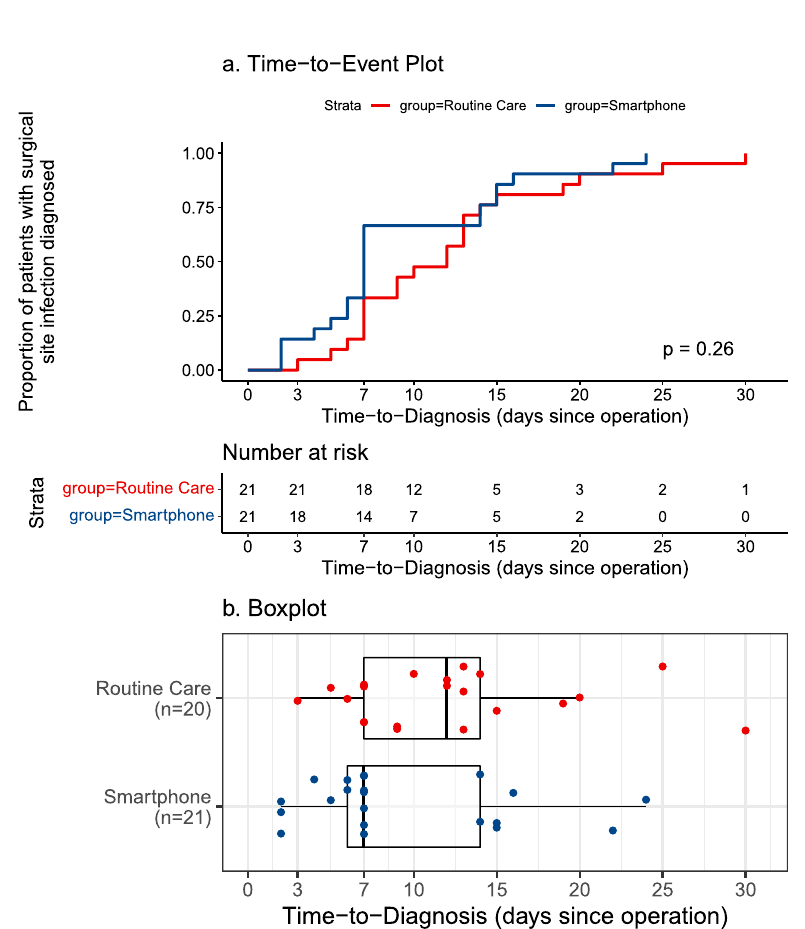
Fig. 2 Time-to-diagnosis (days) of surgical-site infection (SSI). The time-to-diagnosis (days) of patients who were diagnosed with SSI within 30-days as ( a ) time-to-event plot ( b )